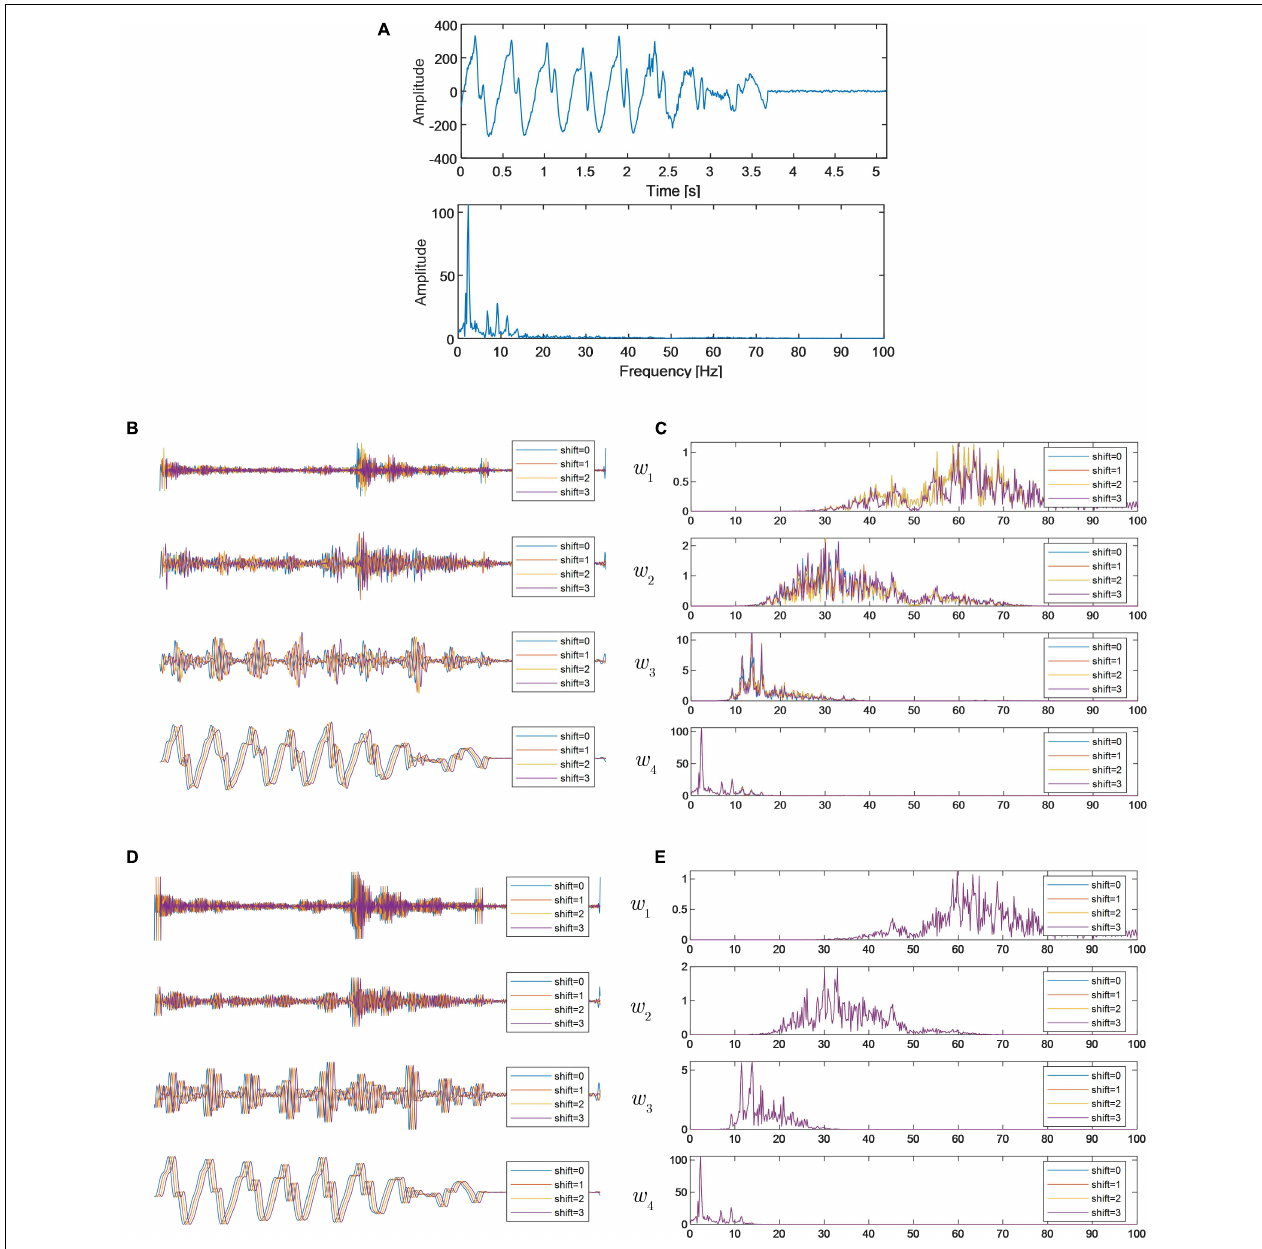
FIGURE 4 | (A) Time domain waveform and FFT spectrum of the investigated EEG signal; (B) wavelet subspaces generated by DWT; (C) FFT spectra of wavelet subspaces generated by DWT; (D) wavelet subspaces generated by RDWT; and (E) FFT spectra of wavelet subspaces generated by